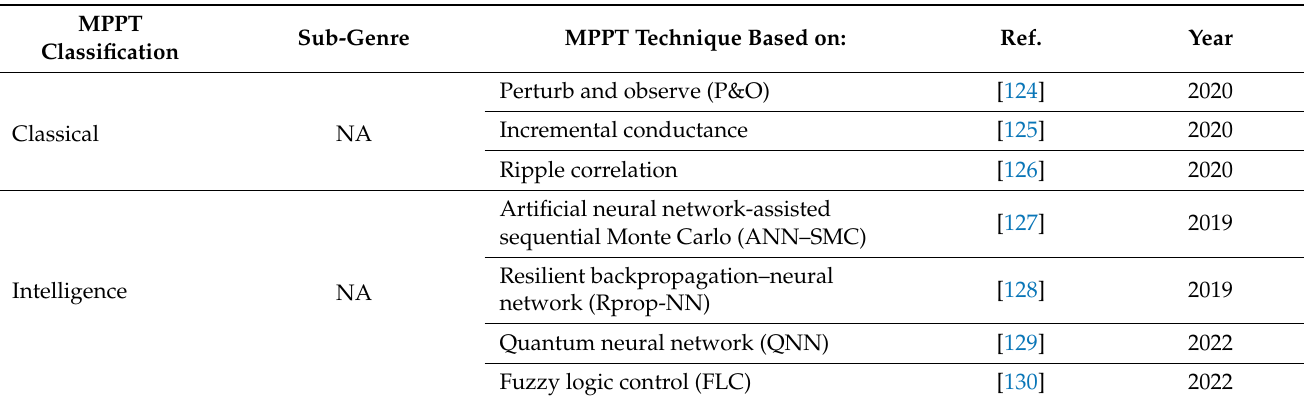
Table 9. Hierarchical development and applications of MPPT techniques under the complete MPPT classification from 2019 to